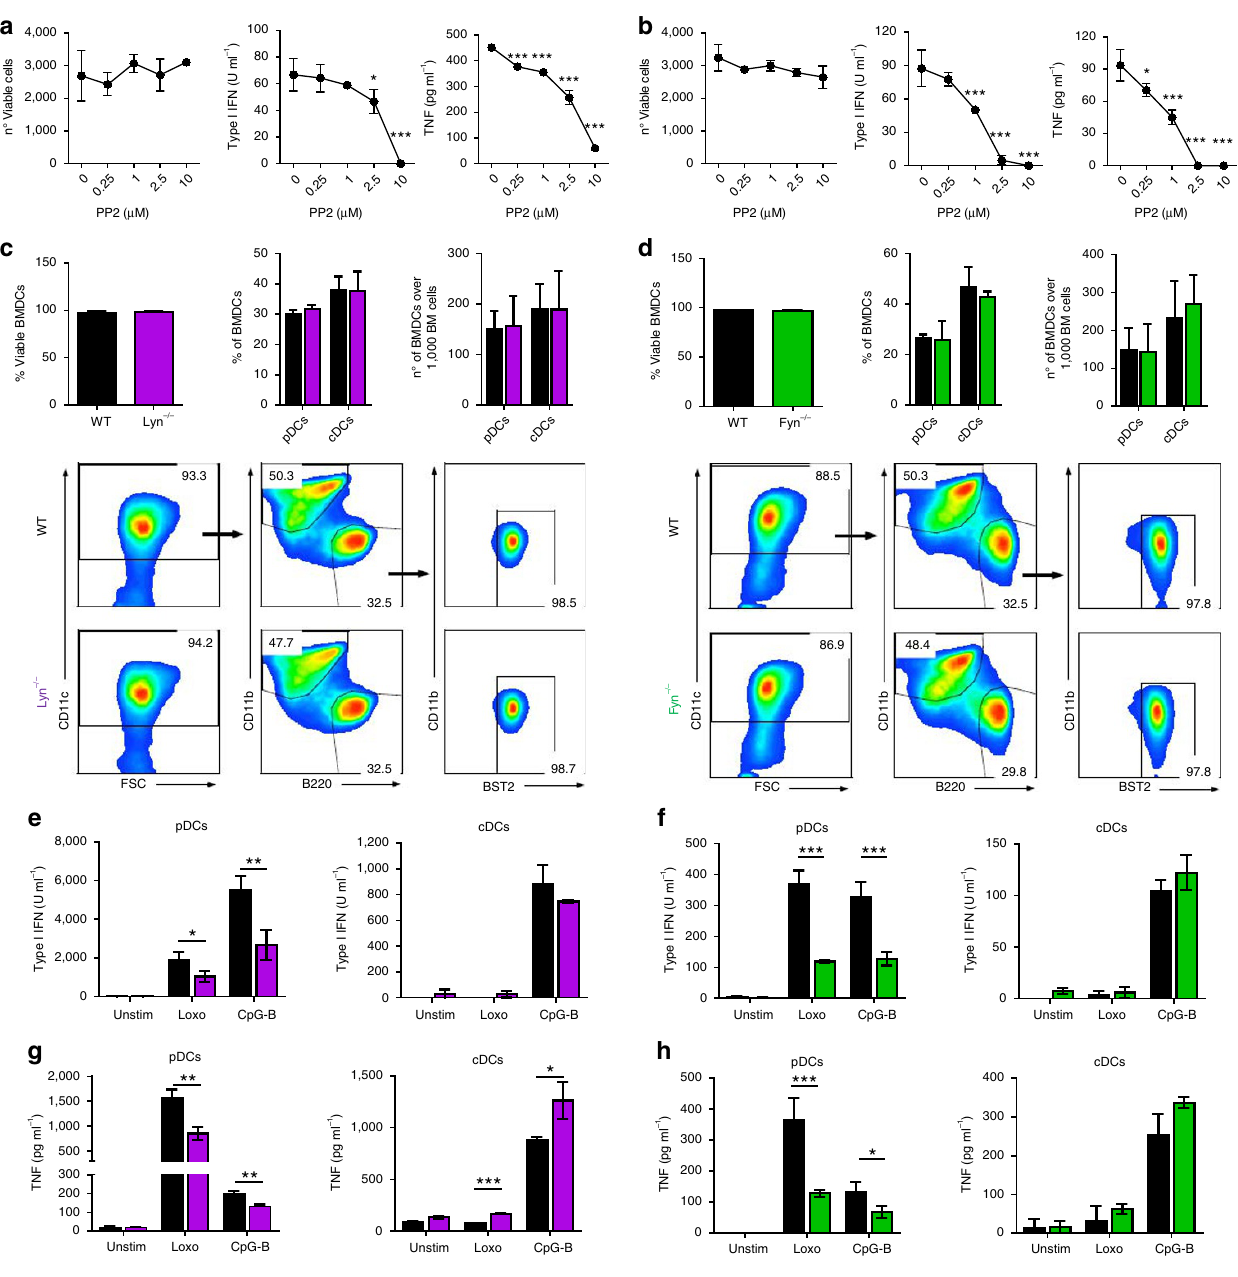
Figure 2 | SFK members Lyn and Fyn are necessary for TLR-induced responses in mouse pDCs. ( a , b ) FACS-purified BM-derived pDCs were pre-treated with PP2 or DMSO control for 1h and then stimulated with CpG-B ( a ) or loxoribine ( b ) for 15h. Cell viability was assessed by flow cytometry, while type I IFN and TNF protein levels in the supernatant were assessed by bioassay and ELISA, respectively. ( c – h ) BM-Flt3L cultures derived from WT (black), Lyn (cid:2) / (cid:2) (violet, c , e , g ) or Fyn (cid:2) / (cid:2) (green, d , f , h ) were collected at day 8 post-culture. DC viability and development were assessed by flow cytometry ( c , d ). pDCs and cDCs were FACS purified and stimulated with CpG-B or loxoribine (loxo) for 15h. Type I IFN activity ( e , f ) and TNF protein level ( g , h ) in the supernatant were assessed by bioassay and ELISA, respectively. Data are representative of two ( a , b ), three ( d , f , h ) or four out of five ( c , e , g ) independent experiments with n ¼ 2 pooled mice per group ( c – h ). Graphs depict mean ± s.d. of replicates within one representative experiment. Dunnett’s multiple comparisons test ( a , b ) and two-way Student’s t -test ( c – h ) were used for statistical analyses. * P o 0.05, ** P o 0.01, *** P o